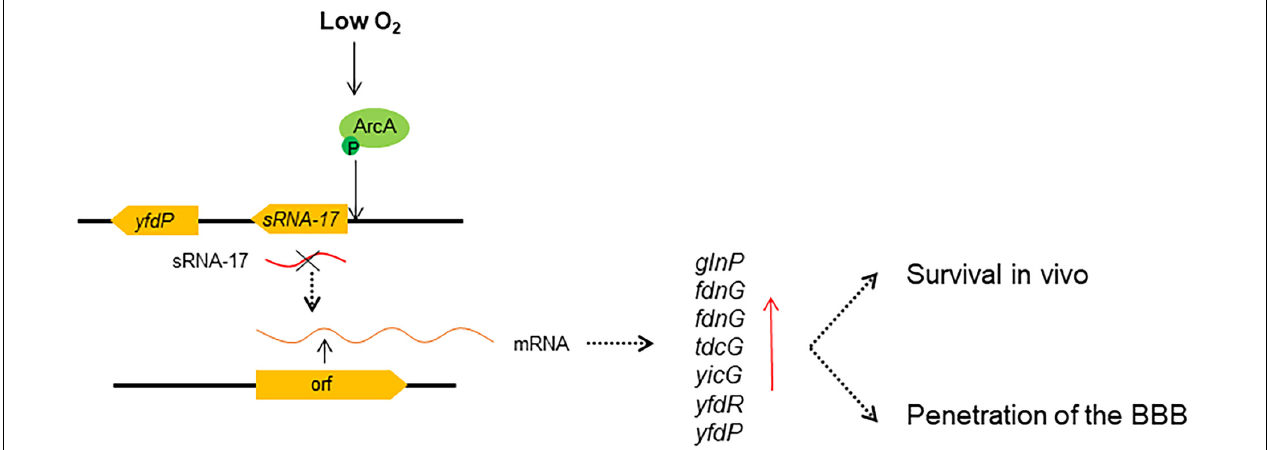
FIGURE 7 | Regulatory model of ArcA and sRNA-17 in response to low oxygen signal. Our findings suggest that under a low-oxygen condition, phosphorylated ArcA binds the sRNA-17 promoter, which may inhibit the transcription of sRNA-17. When the sRNA-17 is absent, the differentially expressed genes benefit bacterial